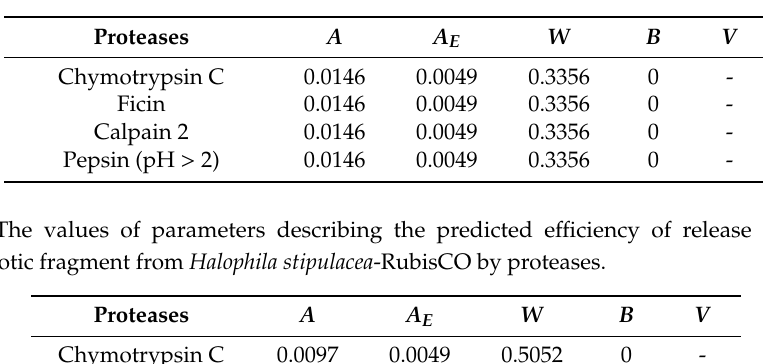
Table 5. The values of parameters describing the predicted e ffi ciency of the release of bioactive regulating fragment from Halophila stipulacea -RubisCO by proteases.